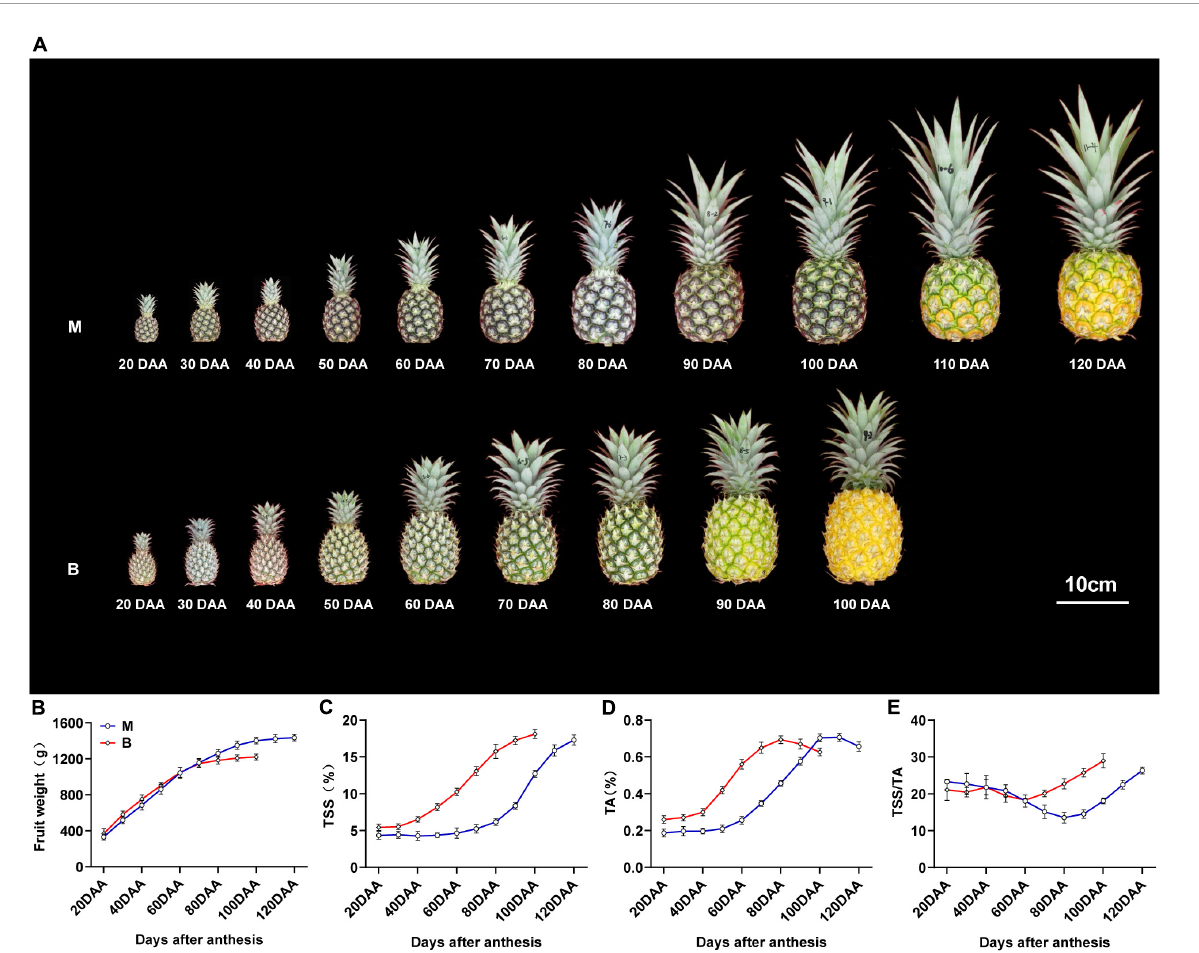
FIGURE1 Changes in fruit morphology and physiological index and fruit weight during fruit development and maturity. (A) Pineapple cultivars M and B fruits at different developmental stages. (B) Fruit weight in the fruit at different developmental stages. (C) TSS in the fruit at different developmental stages. (D) TA in the fruit at different developmental stages. (E) TSS/TA in the fruit at different developmental stages. DAA, days after anthesis; Data were the mean ± standard error from three biological replicate